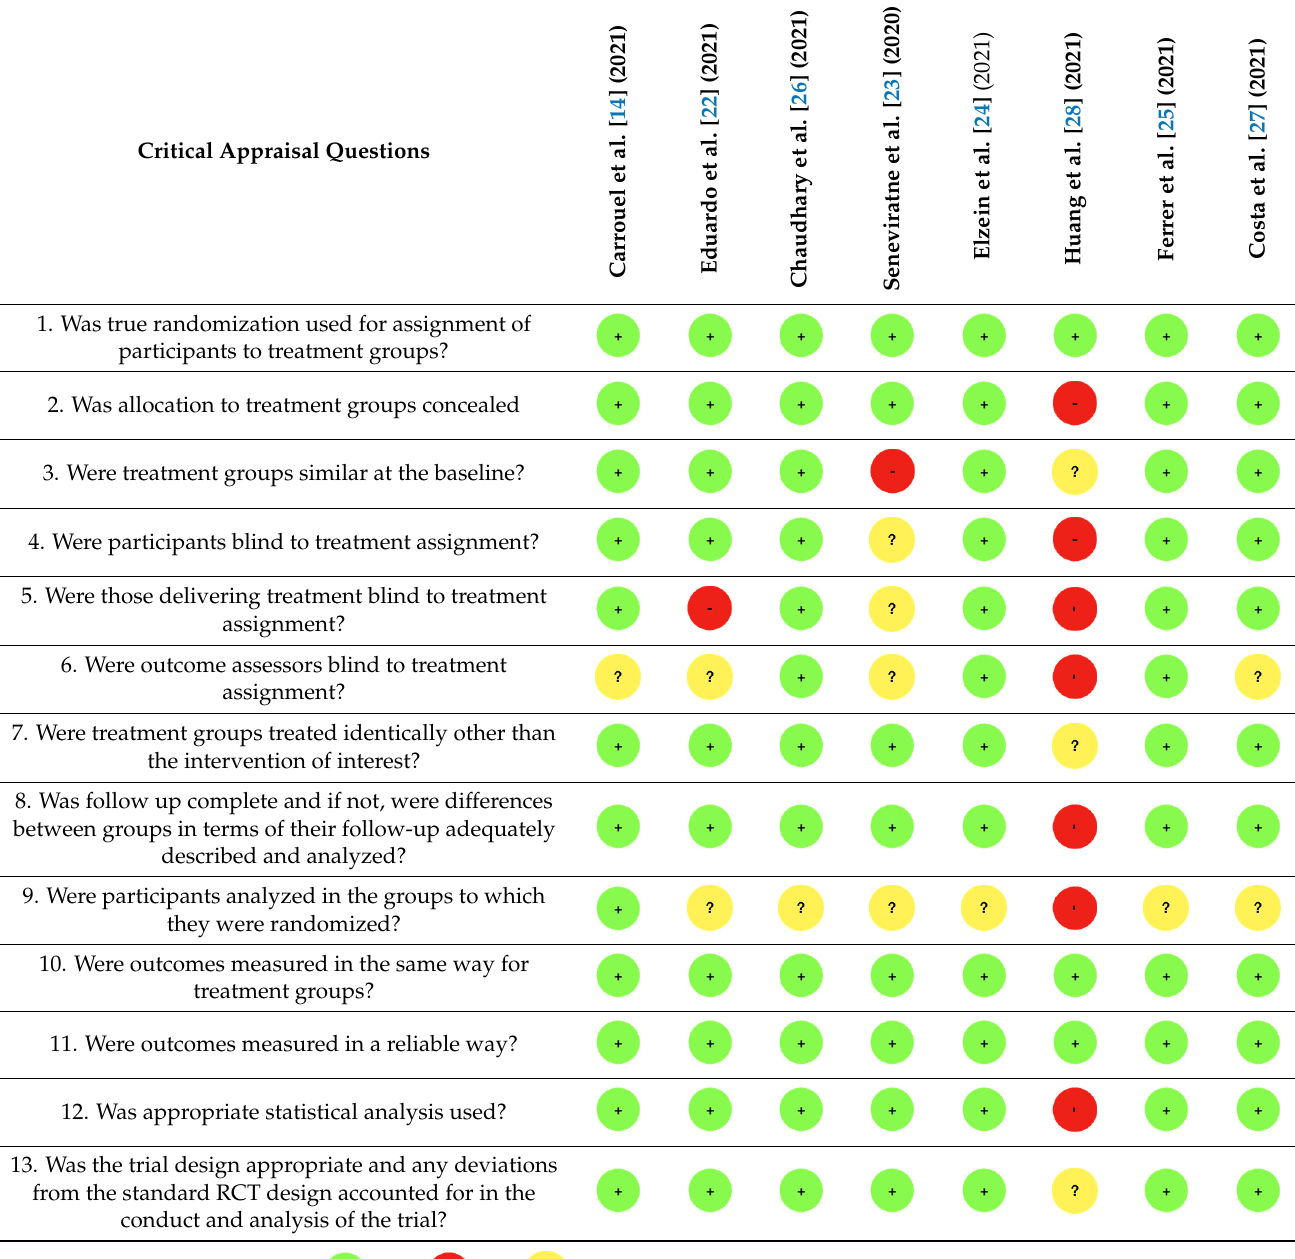
Table 2. JBI Critical Appraisal Tool [21] for RCTs. Reprinted with permission from JBI. Copyright 2020.